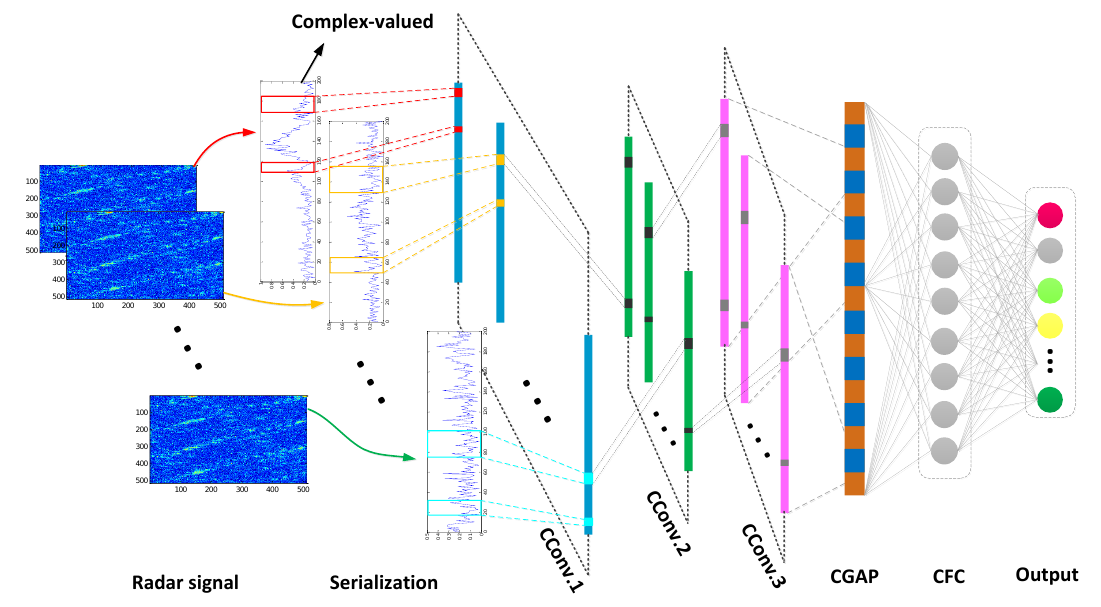
Figure 1. CV-CNN structure framework.